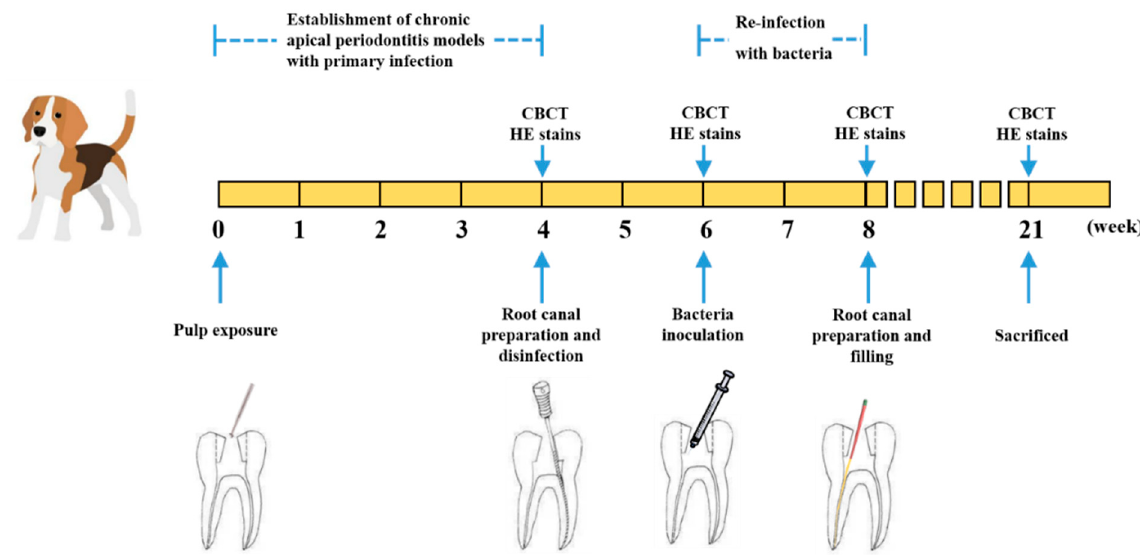
Figure 1. Establishment of E. faecalis and multi-bacteria-induced persistent AP in beagle dogs and filled with DMADDM- modified sealer.